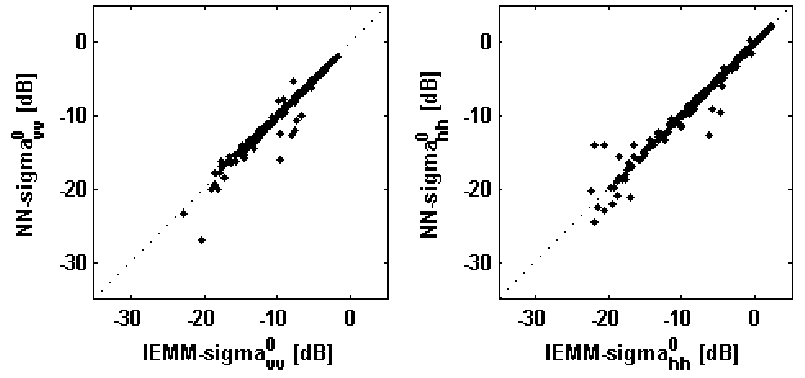
Figure 2. Comparison between IEMM- and NN-derived  0 (test sets of 500 records). Left panels: vertical polarization; right panels: horizontal polarization. Upper panels: L-band; lower panels: C-band. Dotted lines represent perfect